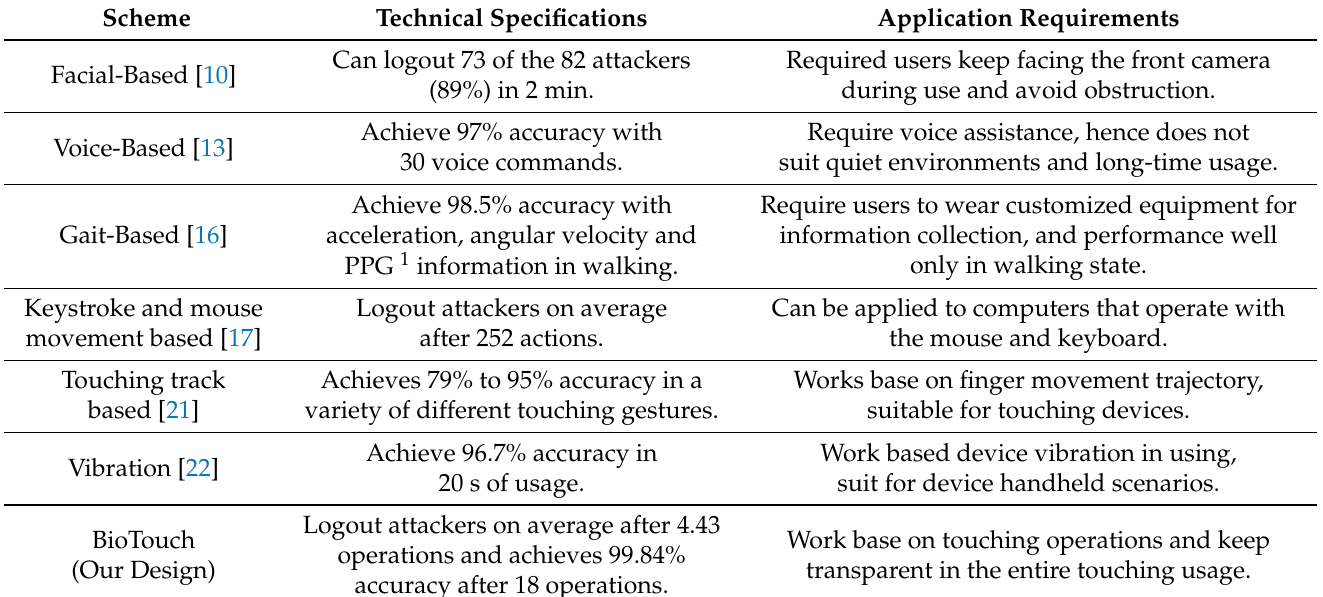
Table 4. Technical specifications and application requirements comparison with different re- authentication